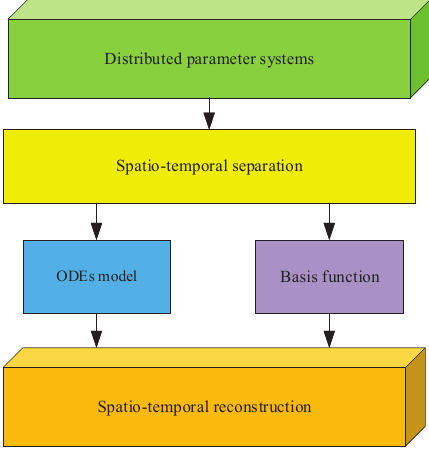
Figure 2. The collocation